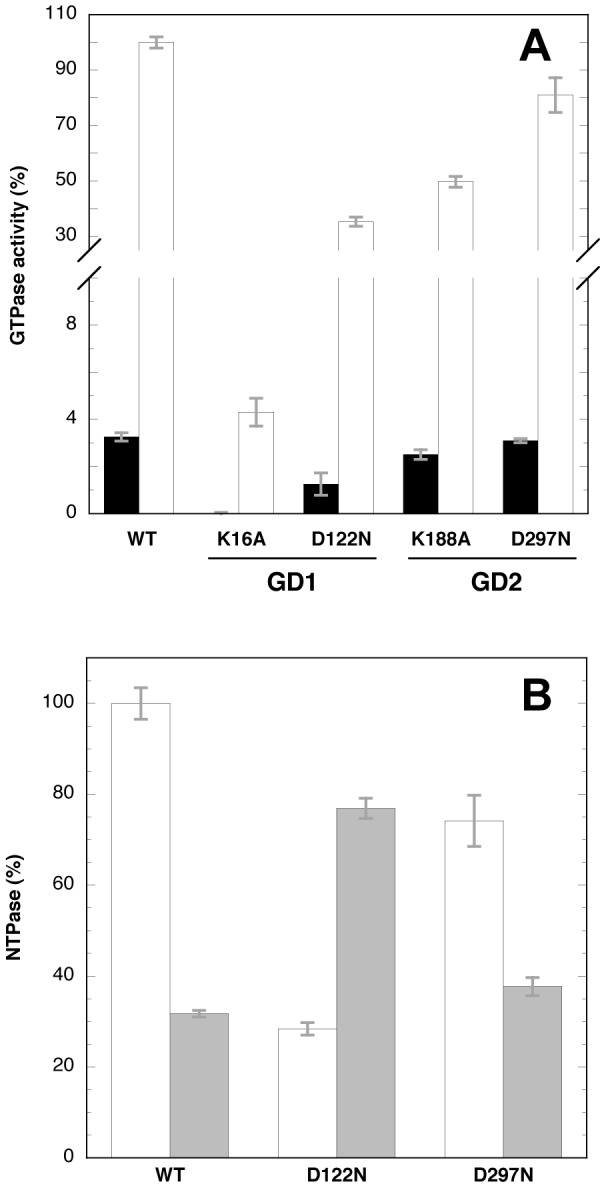
GTPase or XTPase activities of wild-type or mutated EngA.
A, the GTPase activity of the wild-type EngA (WT) or the mutants was measured in the presence of 1 mM GTP using a coupled-enzymatic assay in the absence (black bars) or in the presence of 300 mM KCl (white bars); the results are expressed relative to that of the wild-type EngA in the presence of 300 mM KCl (100% corresponding to 100 µmol GTP hydrolyzed/min/mg proteins). The activity of the K16A mutant is undetectable in the absence of potassium. B, same as A but 200 µM of nucleotides were used in the presence of 300 mM KCl (100% corresponding to 77 µmol GTP hydrolyzed/min/mg proteins); white bars, GTPase activity; grey bars, XTPase activity. The values represent the mean of three experiments and the standard deviation is indicated as error bars, in grey color.